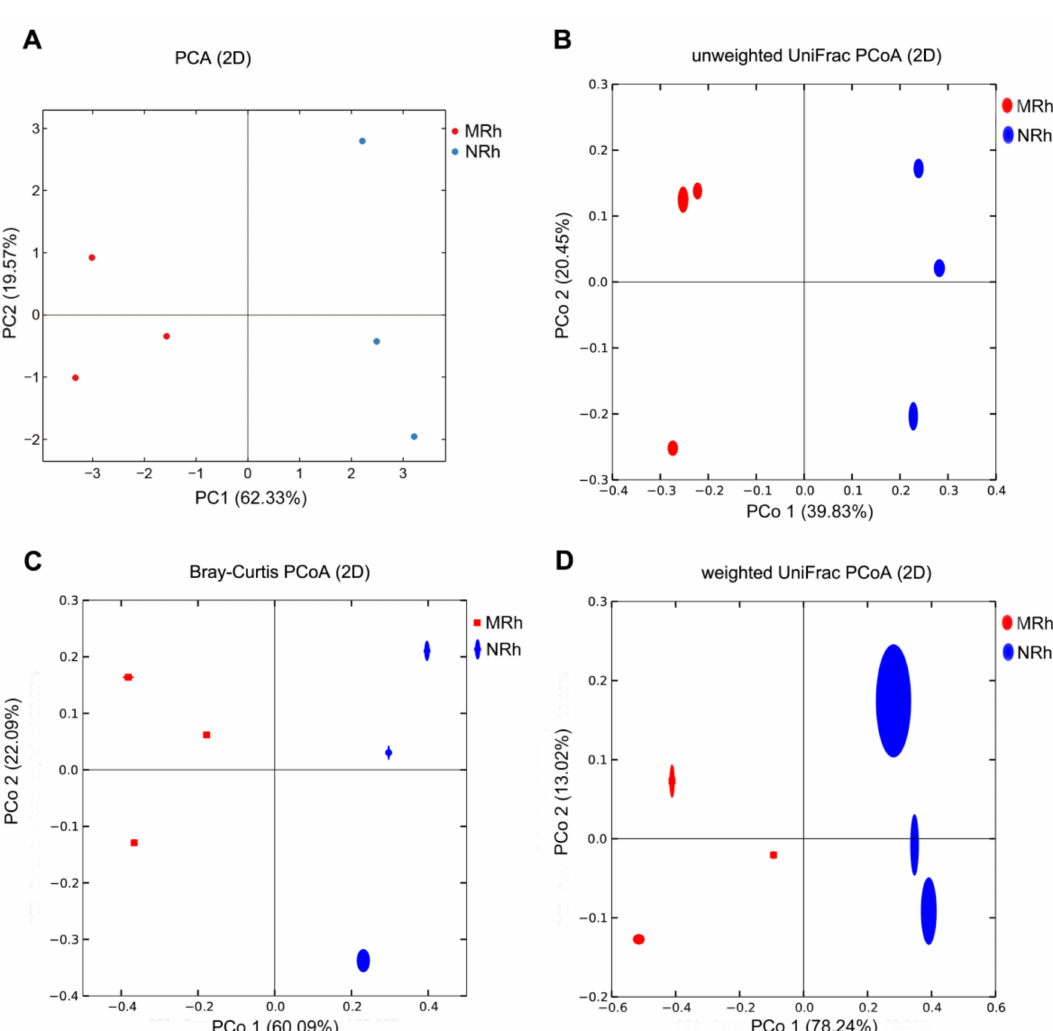
Figure 2. Beta diversity analysis of the rhizosphere bacterial communities between N698 and MD12 (n = 6). Principal component analysis (PCA) based on OTU abundance of bacterial communities ( A ); Numbers in brackets represent contributions of principal components to the total variance; The red and light blue dots represent rhizospheric soil replicates of MD12 (MRh) and those of N698 (NRh), respectively. Principal coordinate analysis (PCoA) based on unweighted UniFrac metrics ( B ), Bray–Curtis metrics ( C ), and weighted UniFrac metrics ( D ); the variance explained by each principal coordinate axis is shown in PCo 1 vs. PCo 2; Red ovals or squares represent MD12, and blue ovals represent